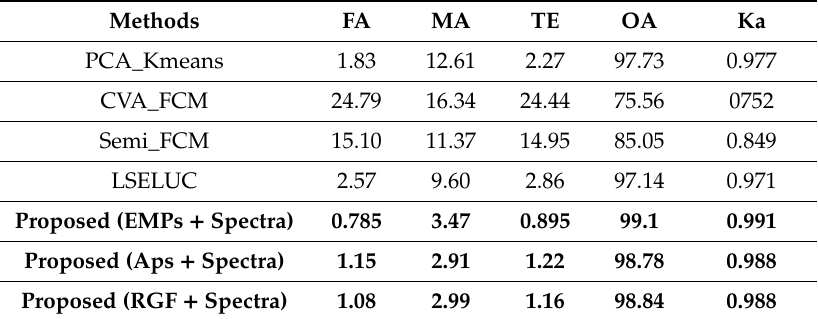
Table 6. Quantitative comparisons (%) between the proposed approach and state-of-the-art methods for Site B VHR bi-temporal remote sensing images.